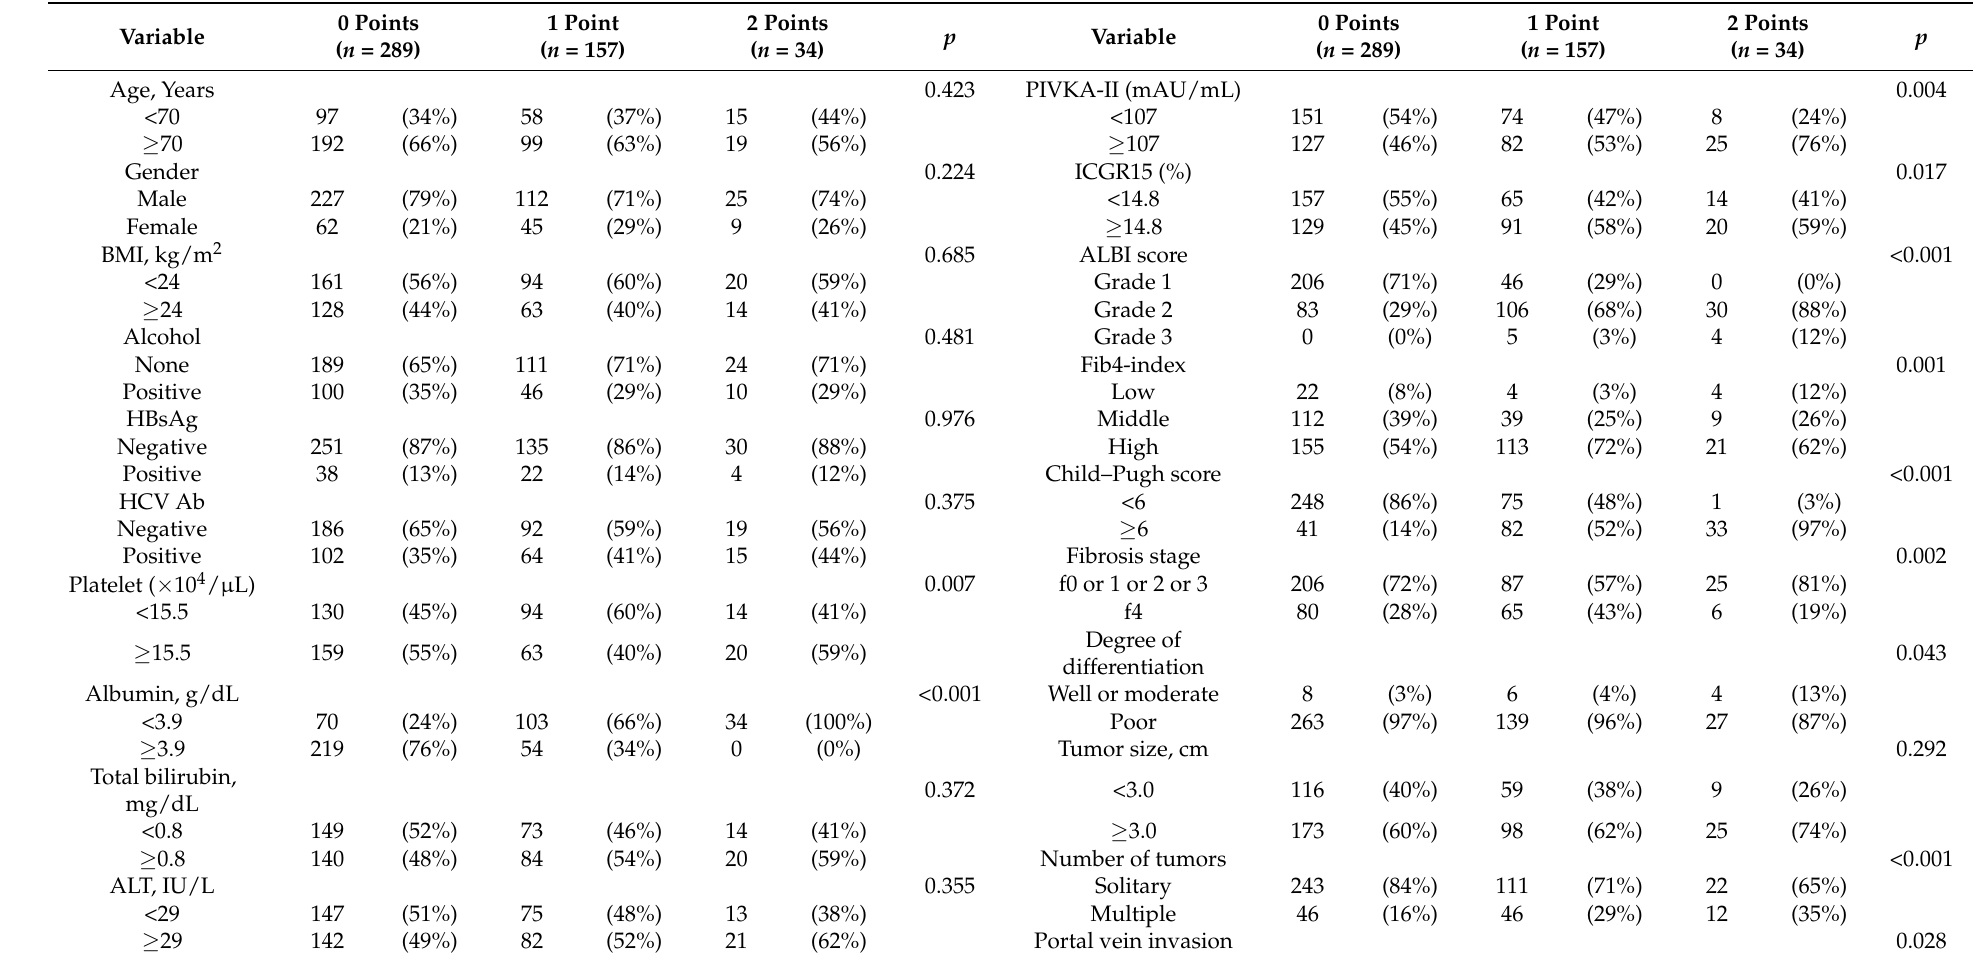
Table 1. Clinical characteristics of 480 patients with hepatocellular carcinoma classified by mALF